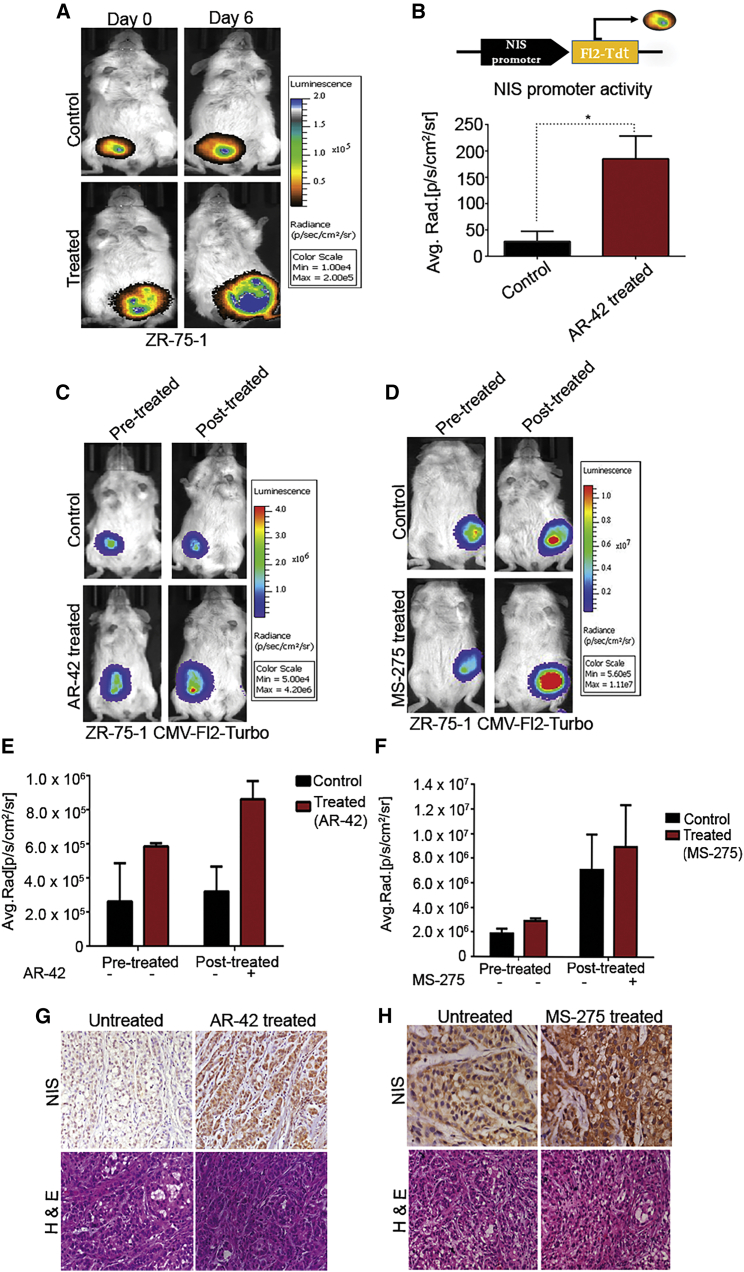
AR-42 and MS-275 Enhance the NIS Promoter Activity and Expression In Vivo(A) Bioluminescence (BLI) images of representative mouse with orthotopic ZR-75-1 NF tumors showing change in NIS promoter activity in untreated control and AR-42 drug-treated groups. (B) Graph showing BLI signal quantified from control and treated groups, normalized to the respective signals before treatment. Error bar indicates SEM (n = 2).∗p ≤ 0.05 calculated by Student’s t test. (C and D) BLI images of representative mouse, AR-42- or MS-275-treated groups, respectively, along with untreated control. Color scale bar indicates photon signal strength (photon/s/cm2/sr). (E and F) Graph showing quantified BLI signal from control and treated mice before and after AR-42 or MS-275 treatment, respectively. Error bar indicates SEM (n = 3). (G and H) Photomicrographs of NIS IHC performed on control and (G) AR-42- or (H) MS-275-treated tumors as marked. DAB staining (brown) and respective hematoxylin and eosin (H&E)-stained images are displayed.